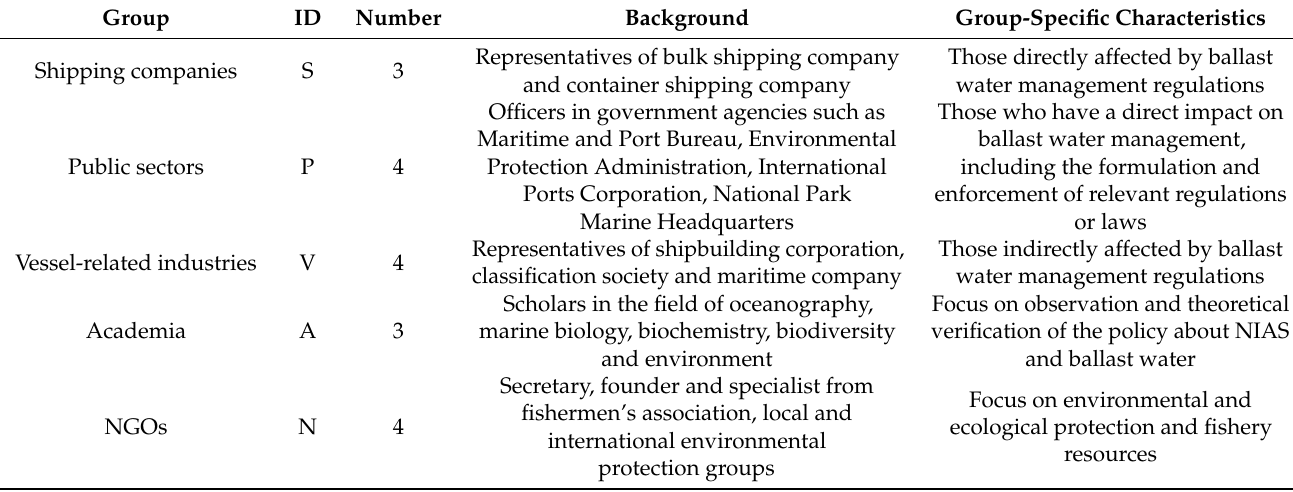
Table 2. Various groups of stakeholders and their